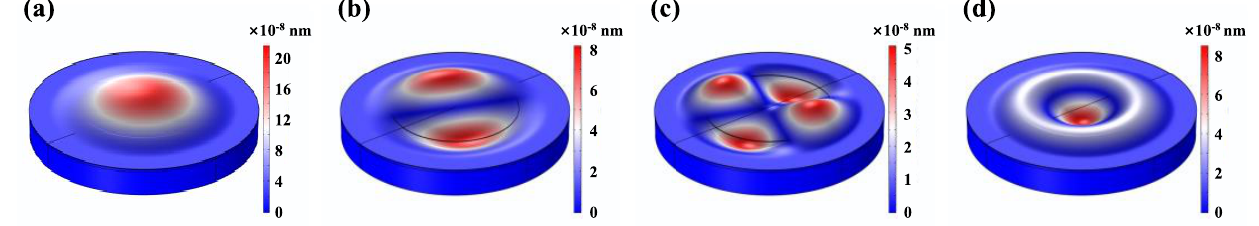
Figure 1. ( a – d ) The front four vibration modes of PMUT.